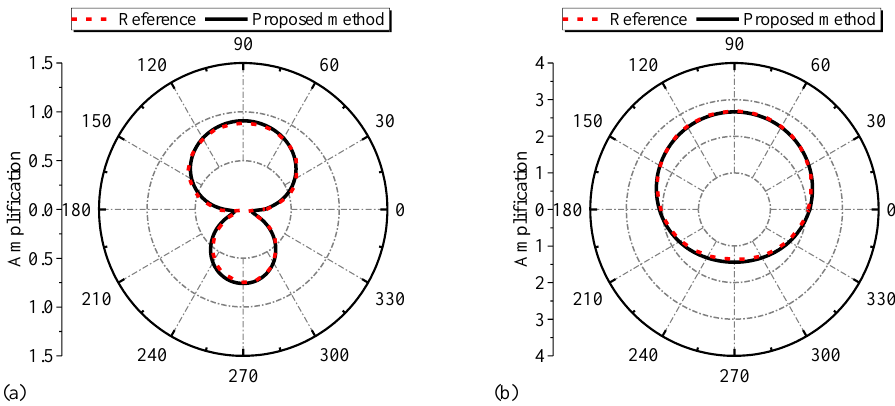
Figure 9. Amplification of radial displacement along the external tunnel surface: ( a ) P wave obliquely incident at 30 ◦ and ( b ) SV wave obliquely incident at 30 ◦ .